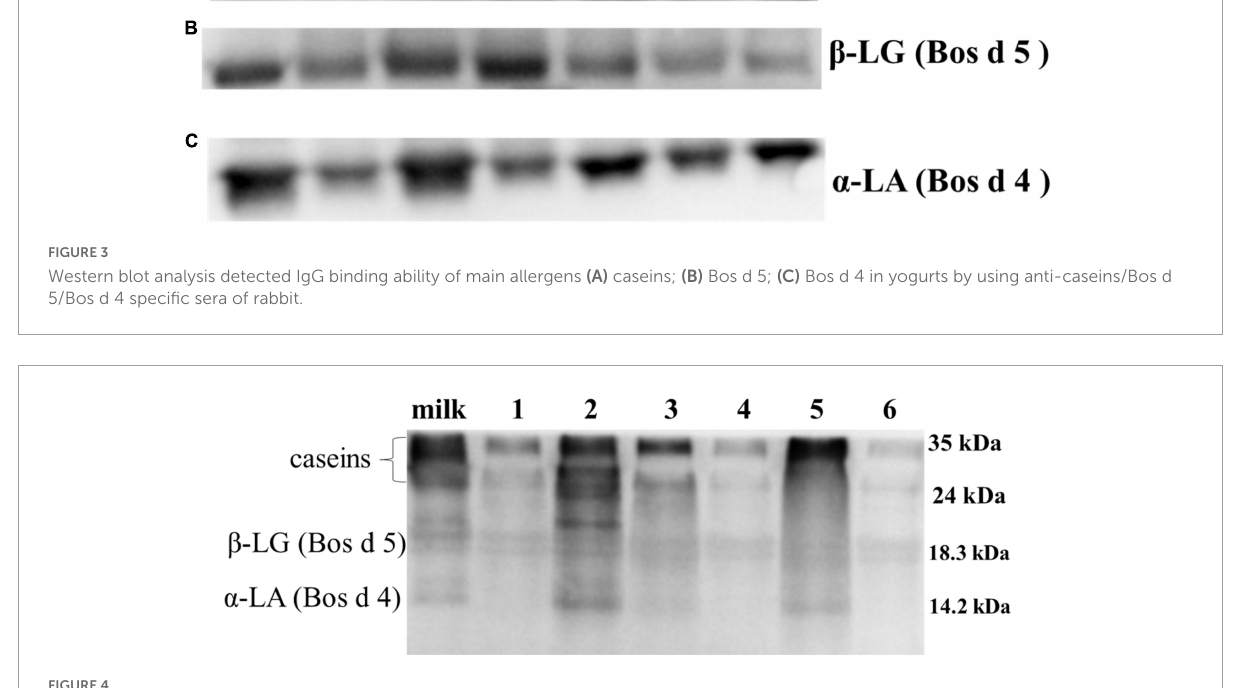
FIGURE4 Western blot analysis detected IgE binding ability of main allergens in yogurts by using sera of allergic patients. Lane 1: GuMi yogurt; Lane 2: JSD yogurt; Lane 3: HR yogurt; Lane 4: HN yogurt; Lane 5: JA yogurt; Lane 6: HS